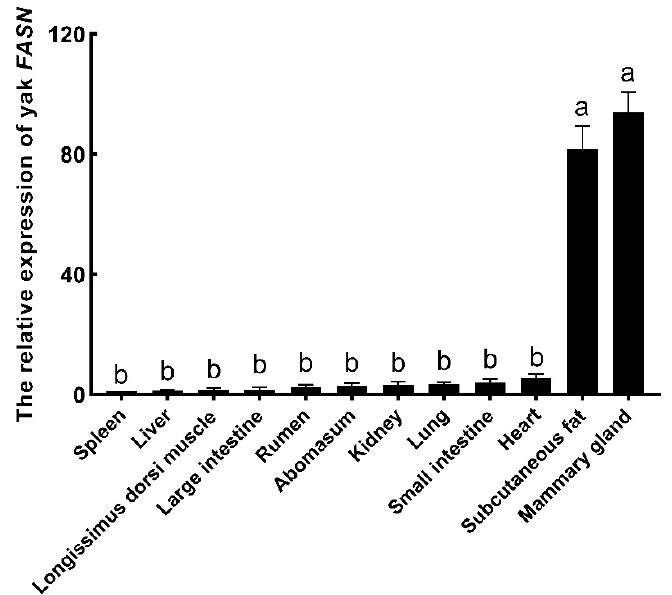
Figure 3. The relative expression of FASN in twelve yak tissues. The spleen was chosen as the control tissue. The error bars indicate standard errors. The different lower-case letters above the columns indicate significant differences ( p < 0.01).